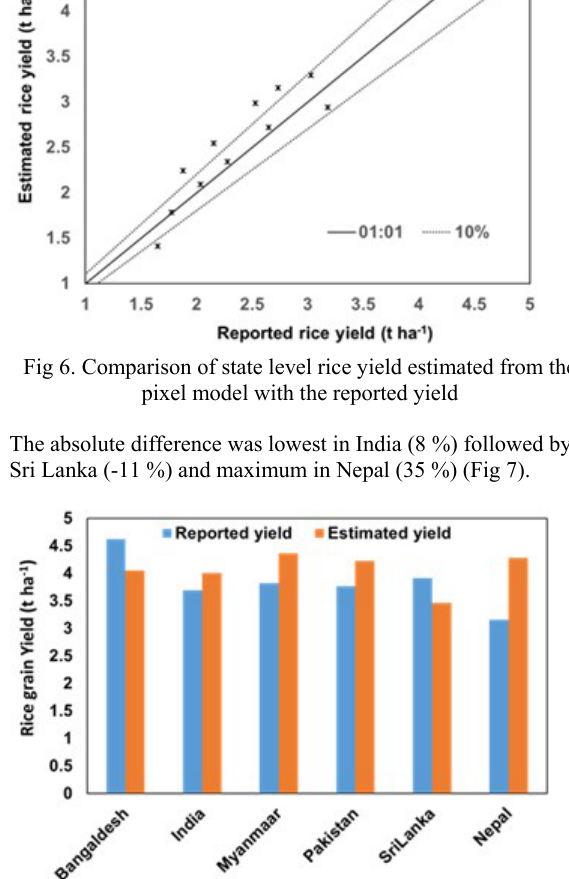
Figure 5. Rice grain yield (t ha -1 ) of six South Asian countries at 2 km resolution using backscatter from SCASAT-1